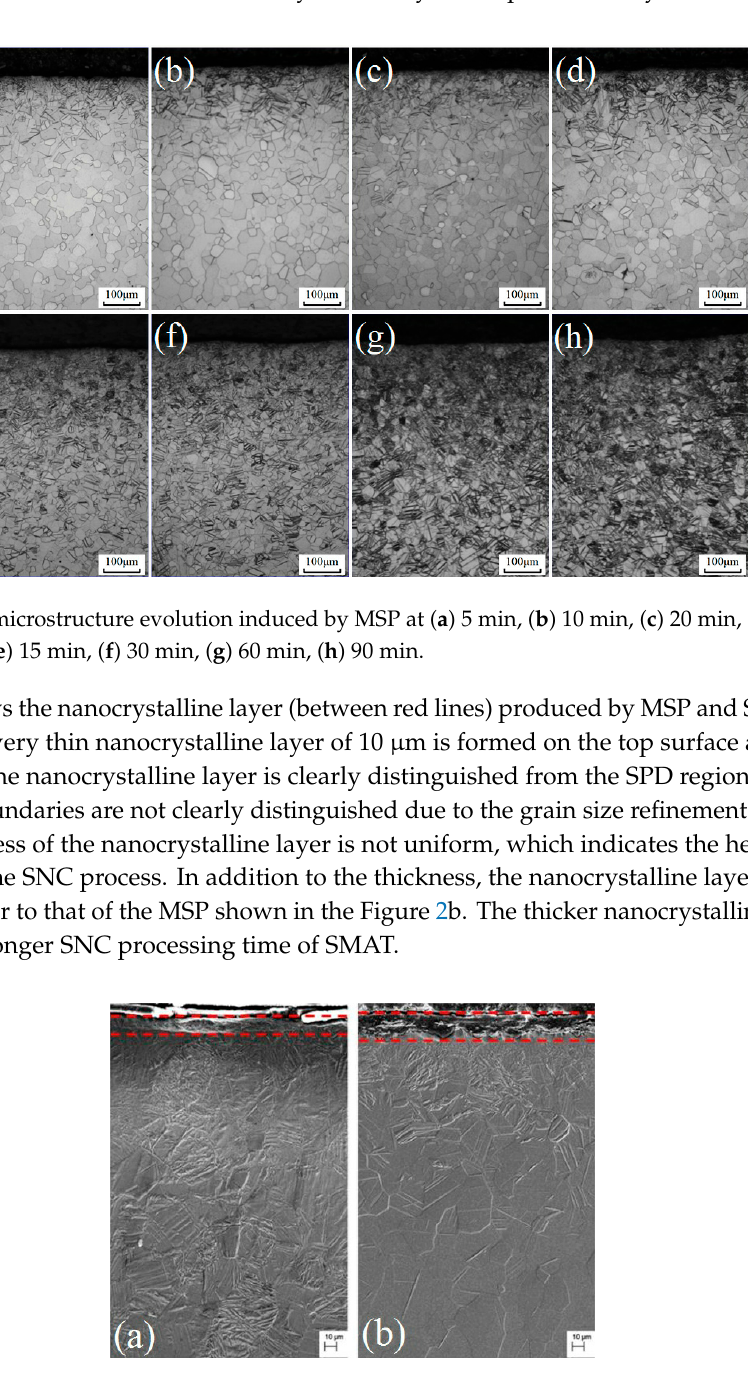
Figure 2. Cross-sectional SEM images of titanium specimens after different treatment conditions: ( a ) MSP for 30 min, ( b ) SMAT for 90 min.